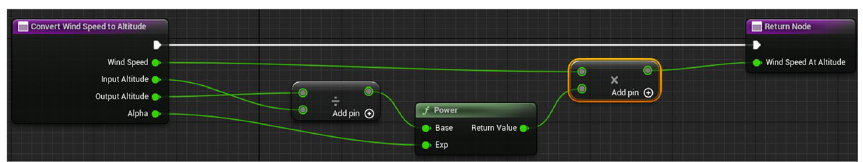
Fig. 12 Implementation of wind profile power